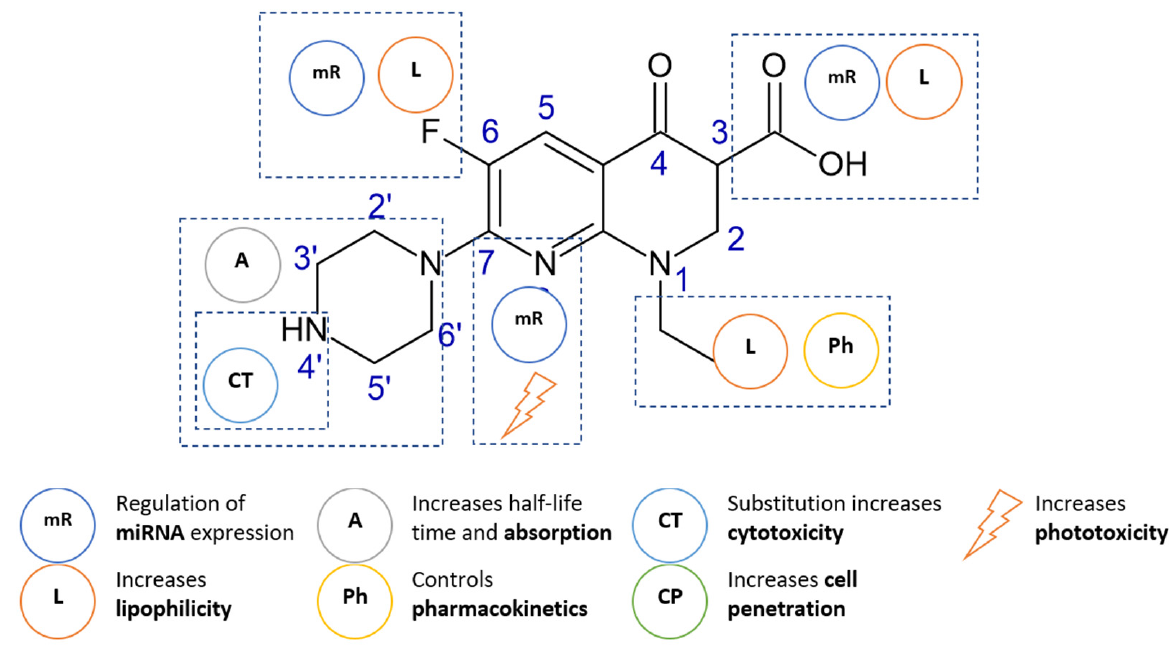
Figure 5. The essential structure requirements of enoxacin as an anticancer agent. Dr. Zhiyu Li synthesized the enoxacin derivative by replacing the carboxyl group with a 2,3-dihydro-1H-benzimidazole-5-carbonitrile system. The derivative was named LZ-106 (Figure 6) [69].